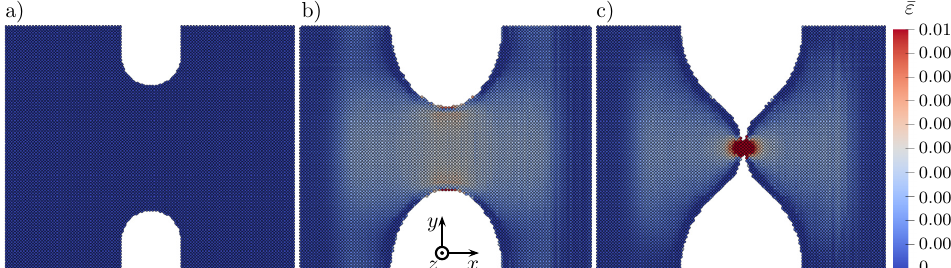
Figure 4. Average discrete strain field ¯ ε , evaluated by Equation (11), at ( a ) the initial state, ( b ) an intermediate state and ( c ) the final